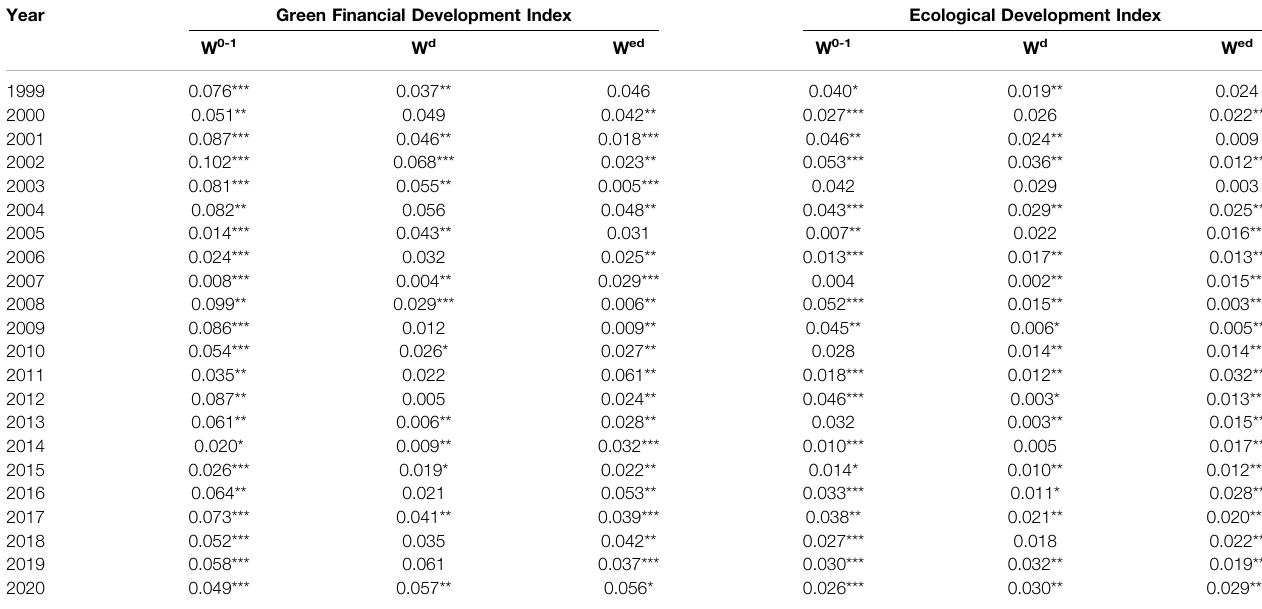
TABLE 1 | Moran ’ s index of the spatial correlation between green fi nance and economic ecological development. Year